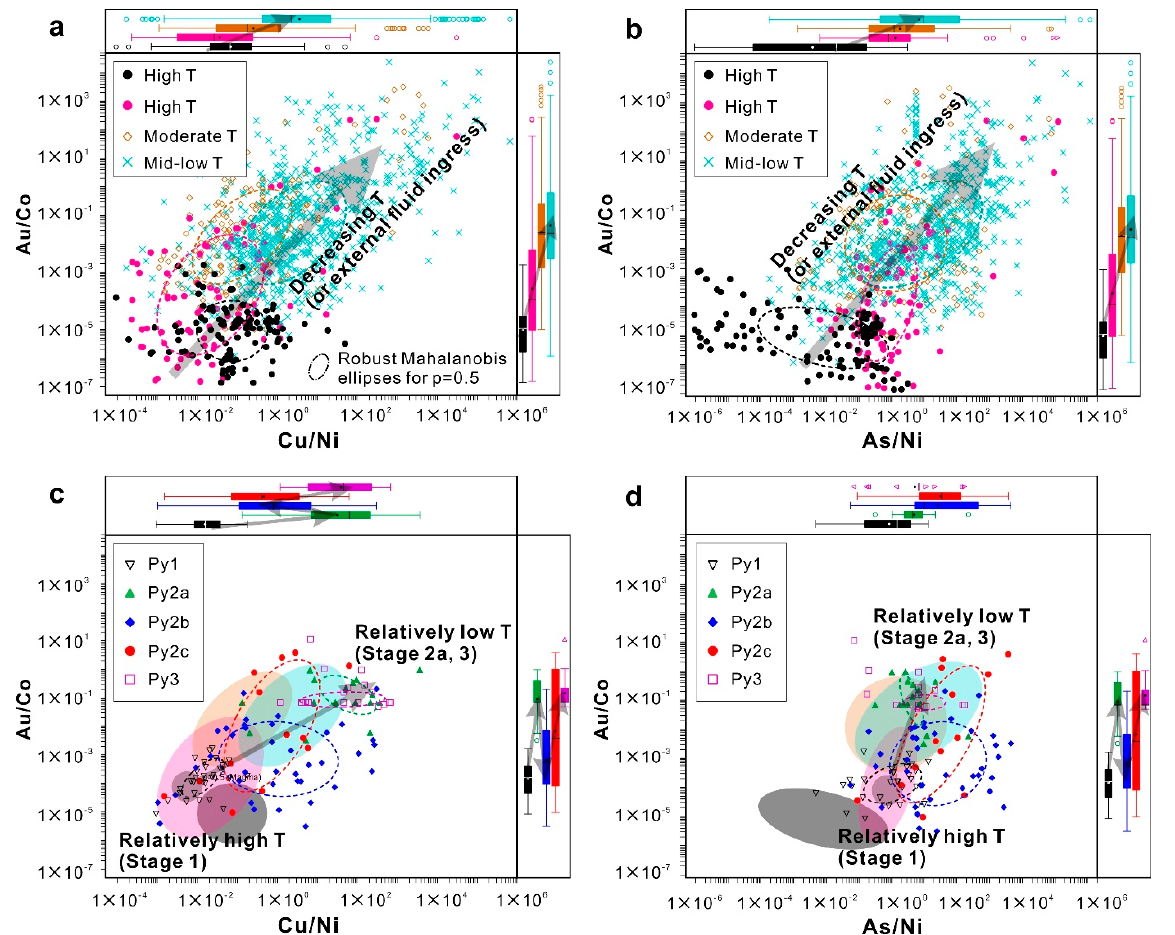
Figure 11. Binary plots of Cu/Ni vs. Au/Co ( a and c ) and As/Ni vs. Au/Co ( b and d ) of pyrite. Pyrite with high T (temperature, black, n = 126), high T (purple, n = 86), moderate T (n = 184), and mid-low T (n = 720) is related to magmatic sulfide deposits (T 350–600 °C), K-silicate alteration of porphyry deposits (T 400–500 °C; [89]), transition from porphyry to epithermal (D-type vein or phyllic-host; T < 400 °C), and epithermal deposits (T < 300 °C), respectively. The arrows show a temperature variation or external waters ingress estimated by Cu/Ni, As/Ni, and Au/Co values. Data were collected from [26,31,35,78,79,88,90–92].